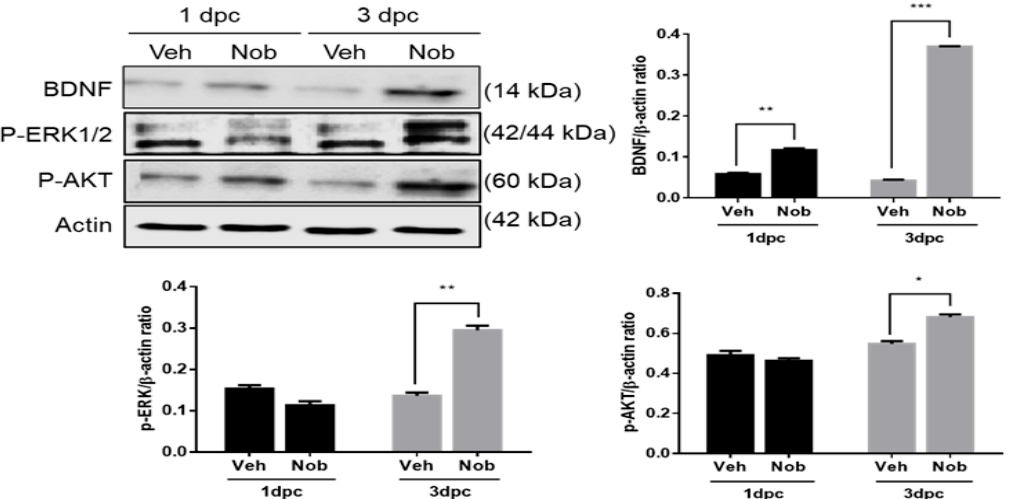
Figure 4. Nobiletin activated BDNF, ERK1/2 and AKT signaling pathways at 3 dpc and facilitated axon growth 2 weeks after SNI. ( a ) At the initial stage of sciatic nerve regeneration, nobiletin enhanced BDNF induction levels in the injured tissues at both 1 and 3 dpc, and ERK1/2 and AKT were significantly activated by nobiletin treatment at only 3 dpc. * p < 0.05, ** p < 0.01, *** p < 0.001 compared to the vehicle treated